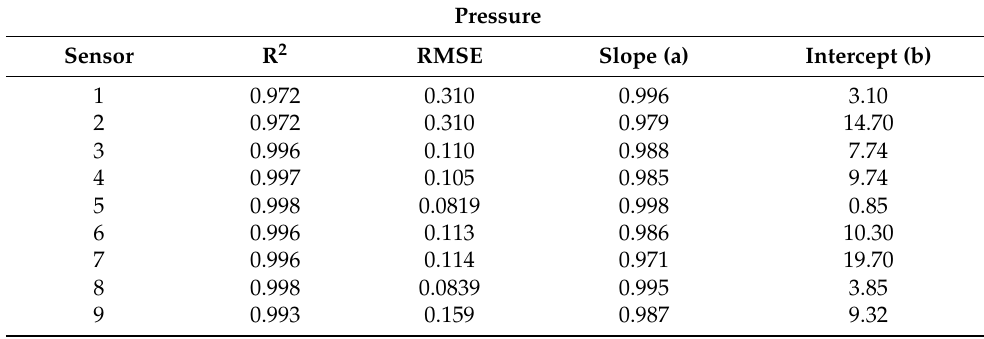
Figure 4. Same as Figure 3 but for pressure. Table 2. Statistical results of the inter-comparison of the Pressure of the GMX500